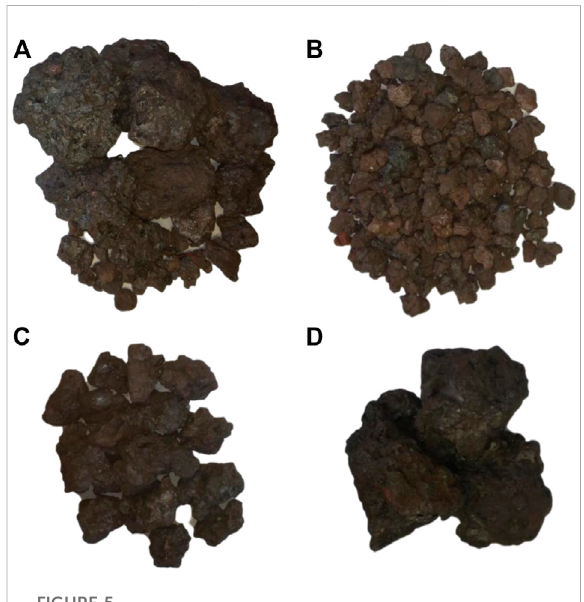
FIGURE 5 (A) Multi-size sinter of 5 – 60 mm; (B) Mono-size sinter of